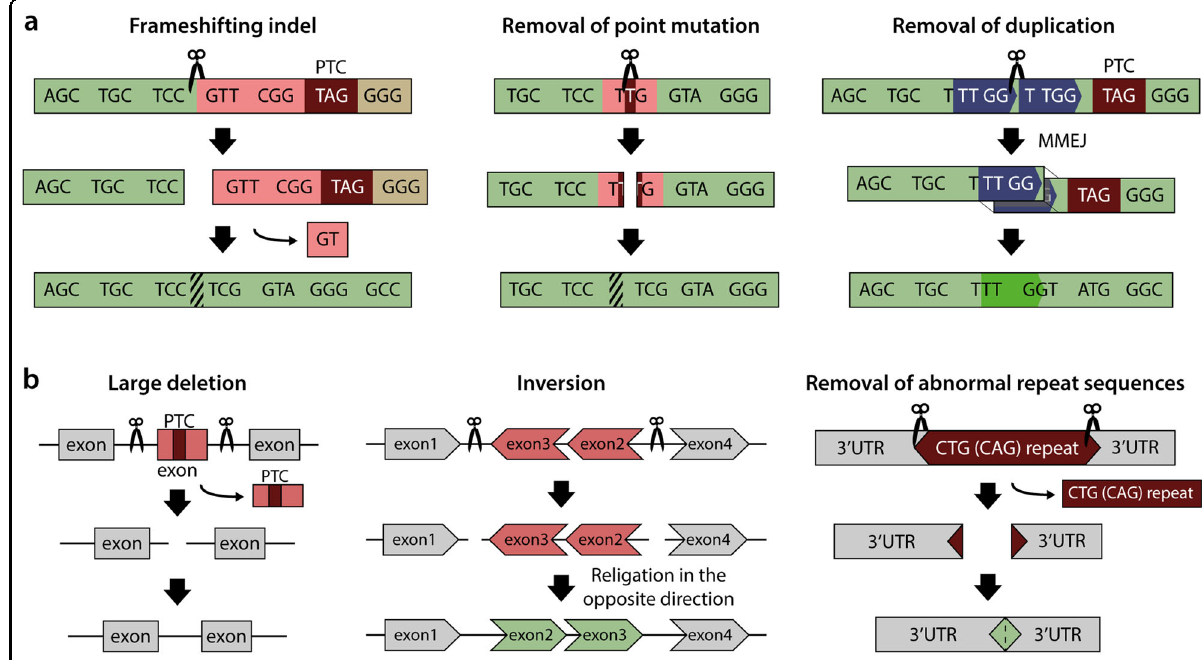
Fig. 2 Gene recovery strategies in the absence of donor DNA. a Gene recovery methods with one guide RNA. b Gene recovery methods with dual guide RNAs. PTC premature termination